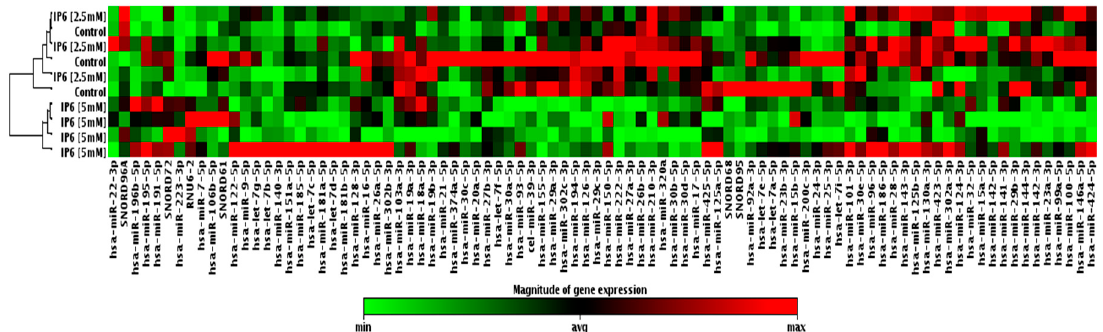
Figure 2. Clustergram and heatmap graph represents the expression level of 84 microRNAs (miRNAs) in untreated cells and Caco-2 treated with IP6 at concentrations of 2.5 mM and 5 mM.